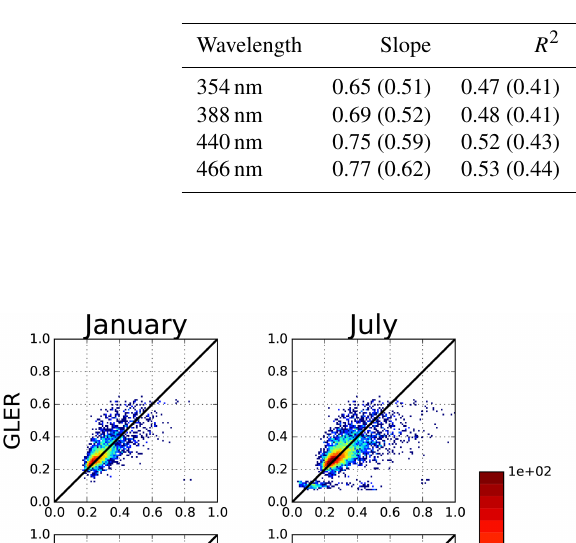
Table 3. Statistical analysis of GLER vs. OMI LER for sunglint-only scenes. January (July) 2006 deep ocean only.